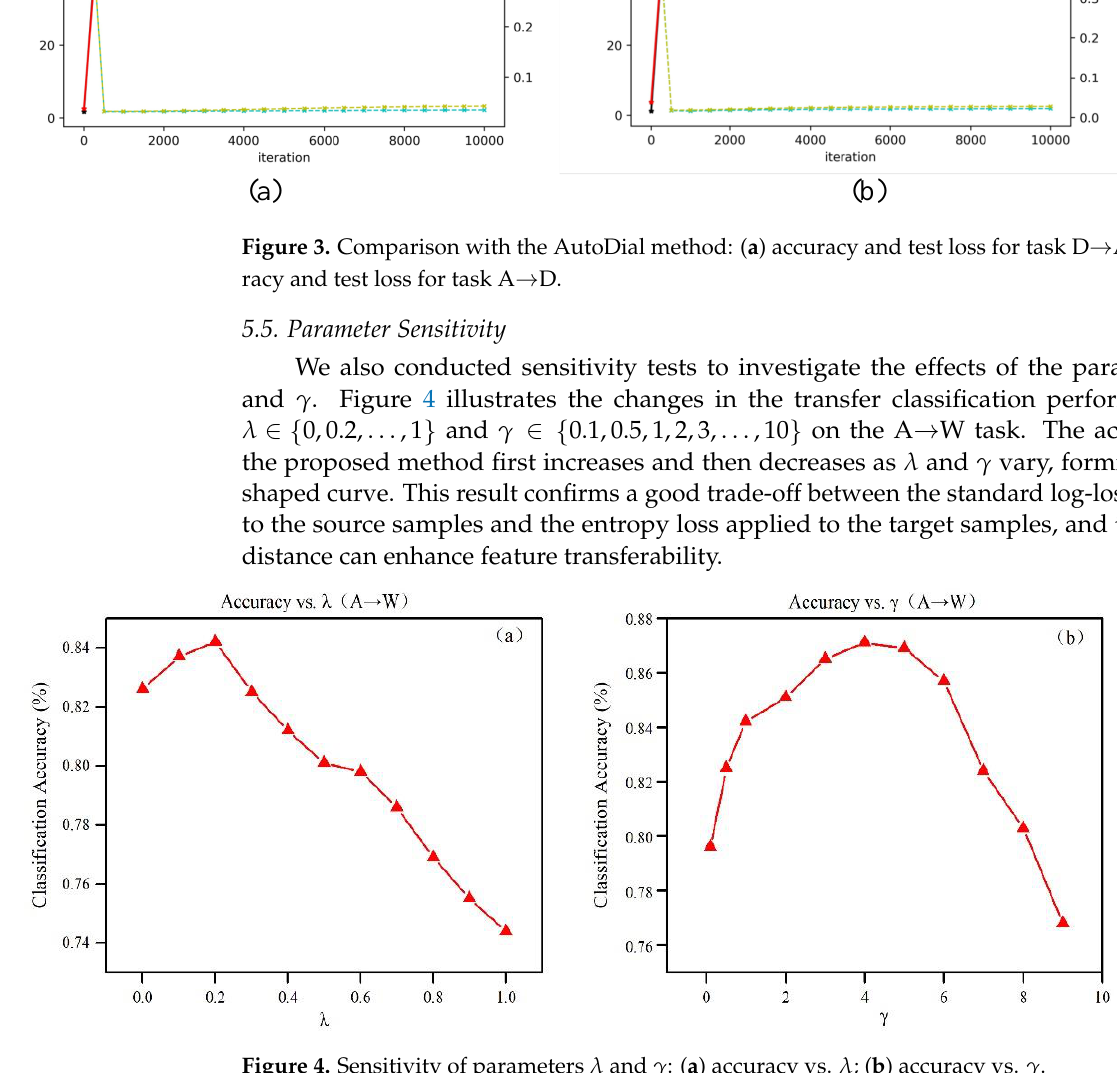
Figure 4. Sensitivity of parameters λ and γ : ( a ) accuracy vs. λ ; ( b ) accuracy vs. γ .